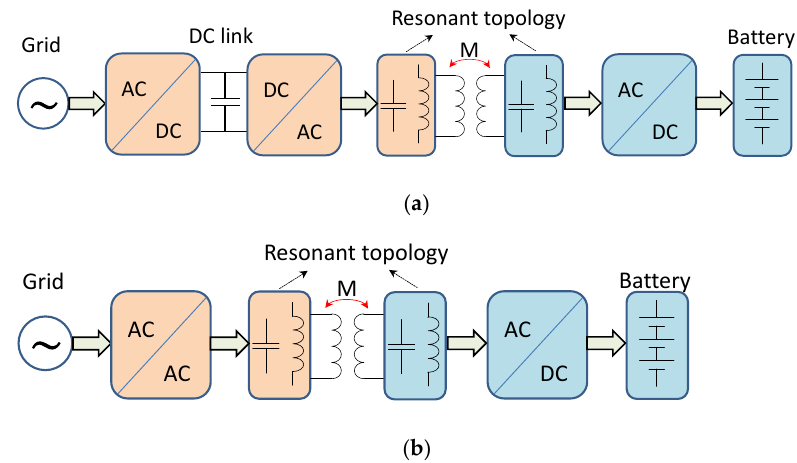
Figure 1. Primary side configurations of IPT: ( a ) Dual ‐ stage; and ( b ) Single ‐ stage.